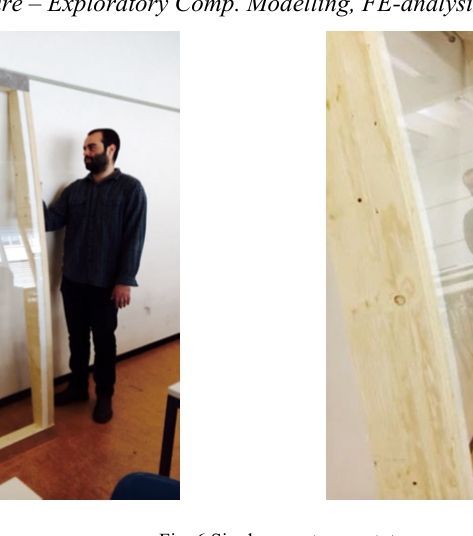
Fig. 6 Single curvature prototype.